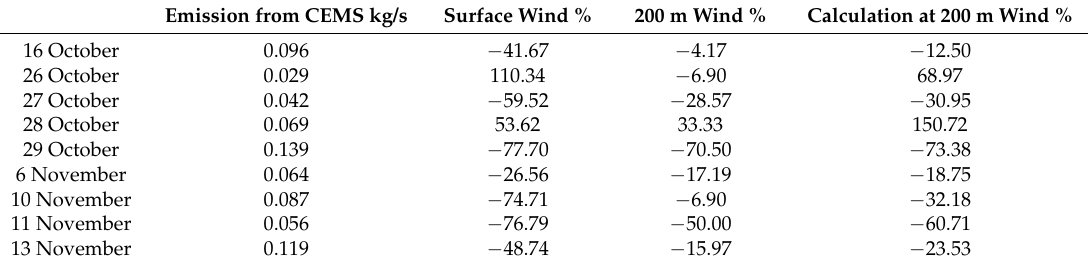
Table 1. Comparison of SO 2 emission between mobile DOAS for three different winds and CEMS. The percentage indicates the deviation with respect to emission from CEMS. The negative values imply that CEMS is lower than those from mobile DOAS; the positive values imply